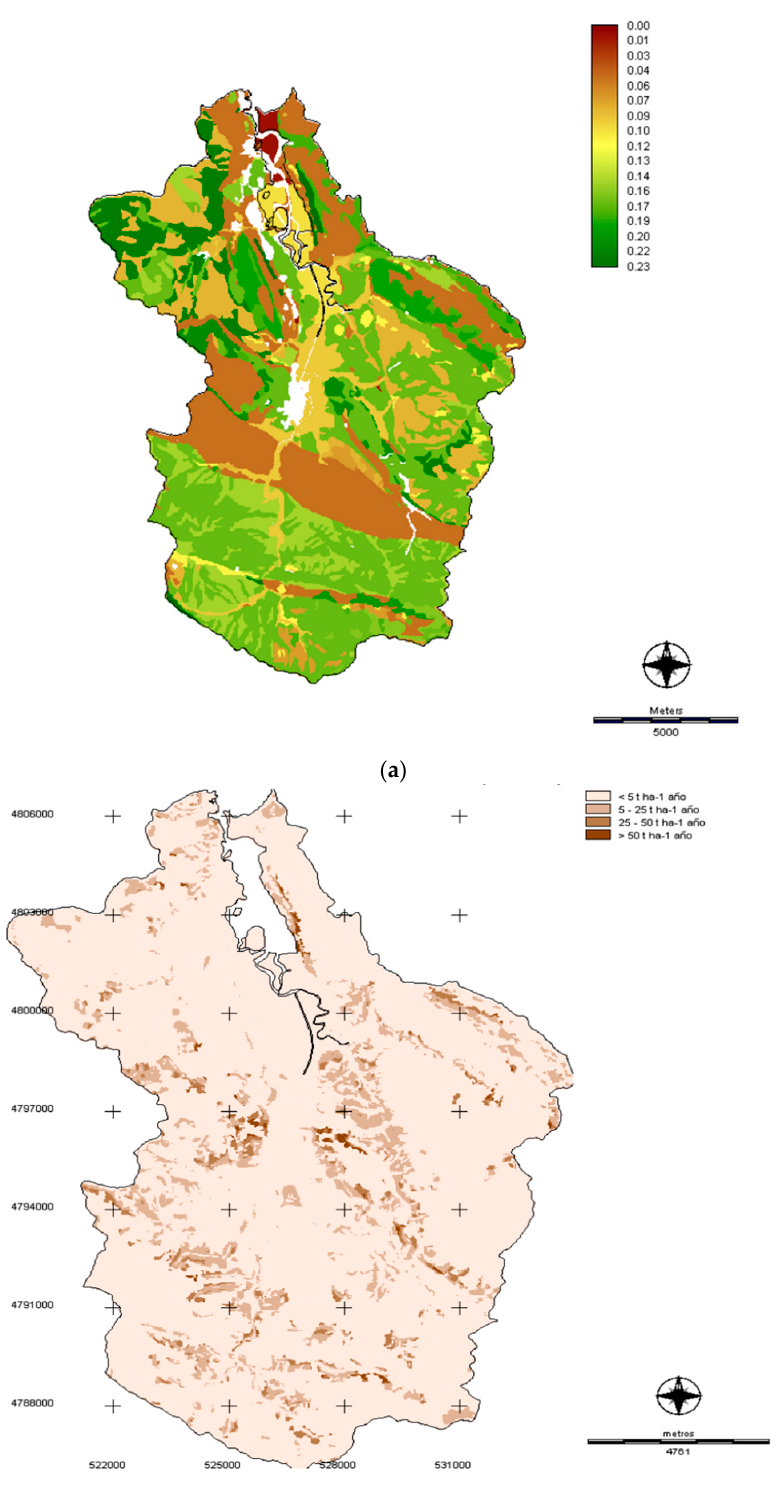
Figure 6. Maps of the Oka River Basin. ( a ) soil erodibility map; ( b ) soil loss map.